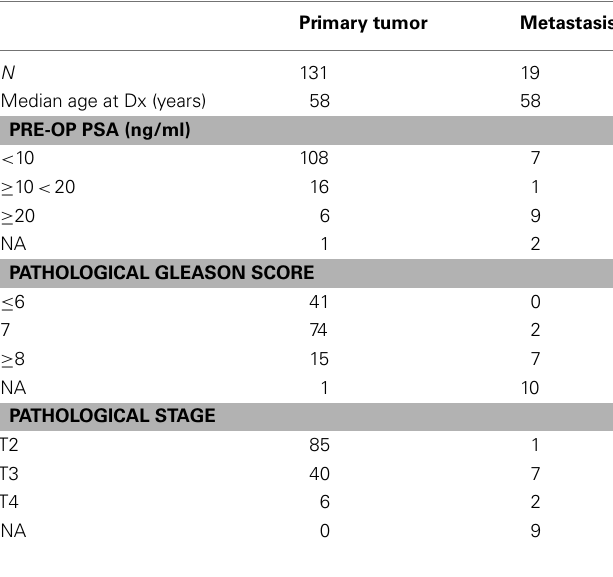
Table 1 | Summary of the clinical characteristics of the dataset used in this